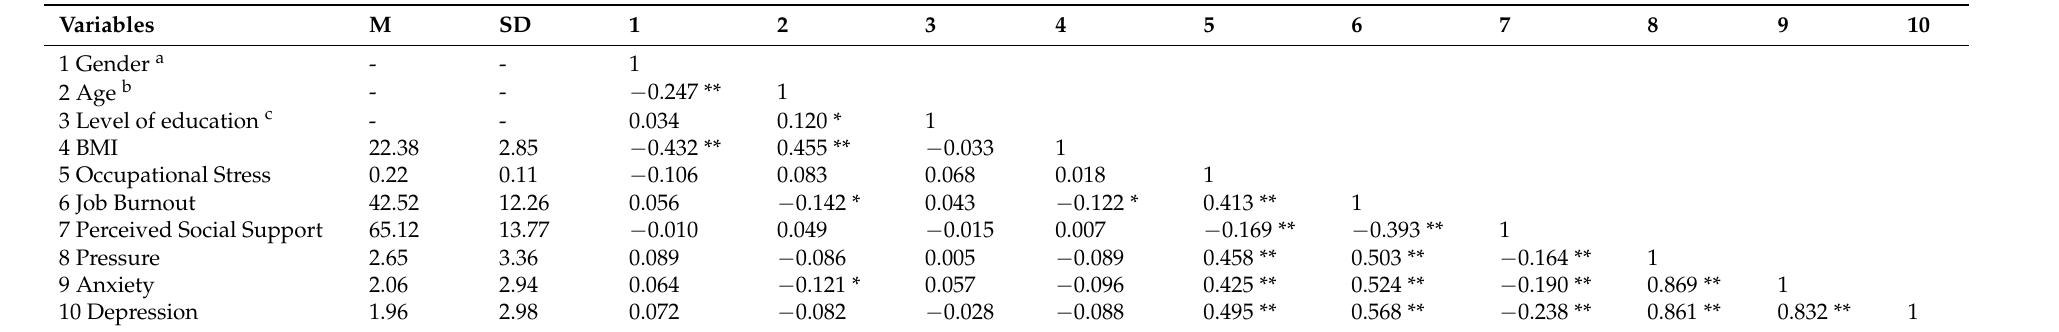
Table 1. Means, standard deviation and correlations of